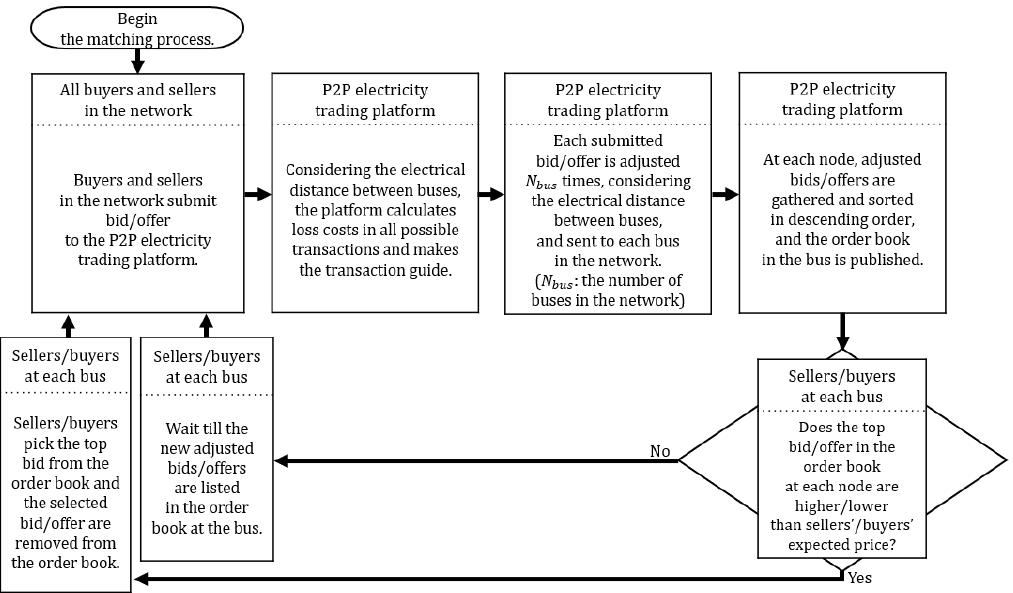
Figure 3. Flow chart of the matching process in the new loss management framework with ex-ante allocation.